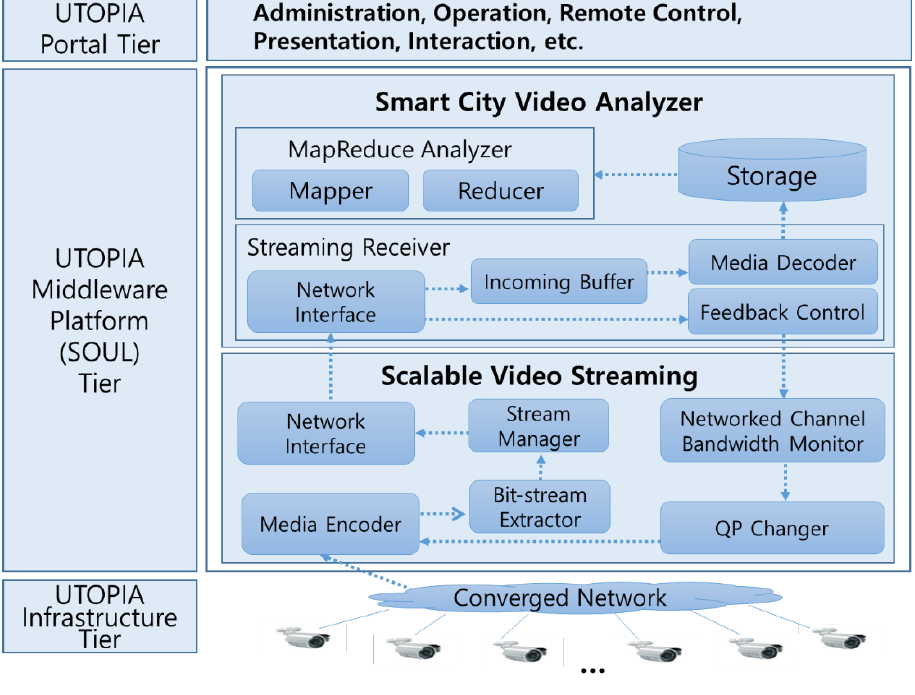
Figure 3. The operation of the USVS.